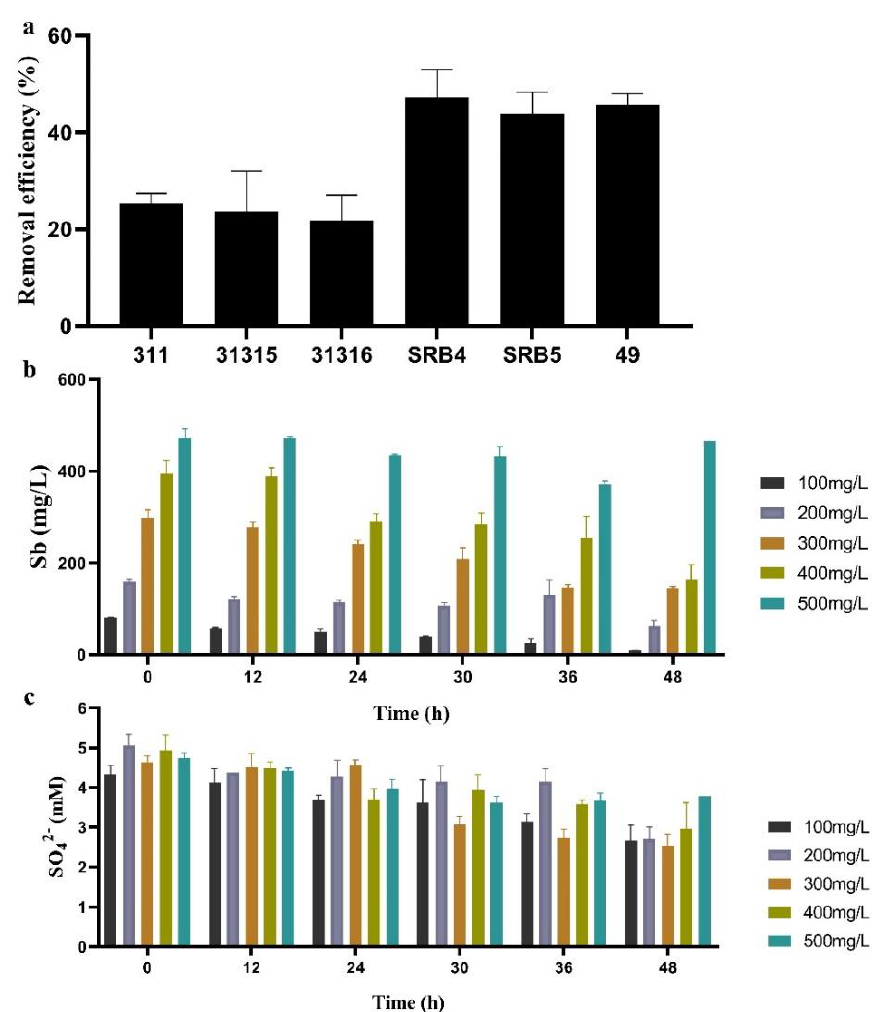
Figure 3. The Sb-removal efficiency of all SRB strains within 24 h ( a ), the performance of SRB49 on Sb removal ( b ) and sulfate consumption ( c ) within 48 h in different Sb(V) concentrations.